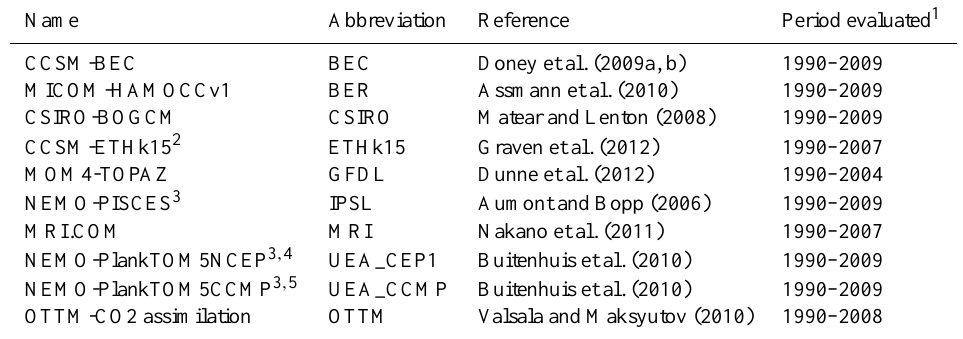
Table 2. List of prognostic ocean biogeochemistry/general circulation models and a p CO 2 sw data-assimilation system included in this study.